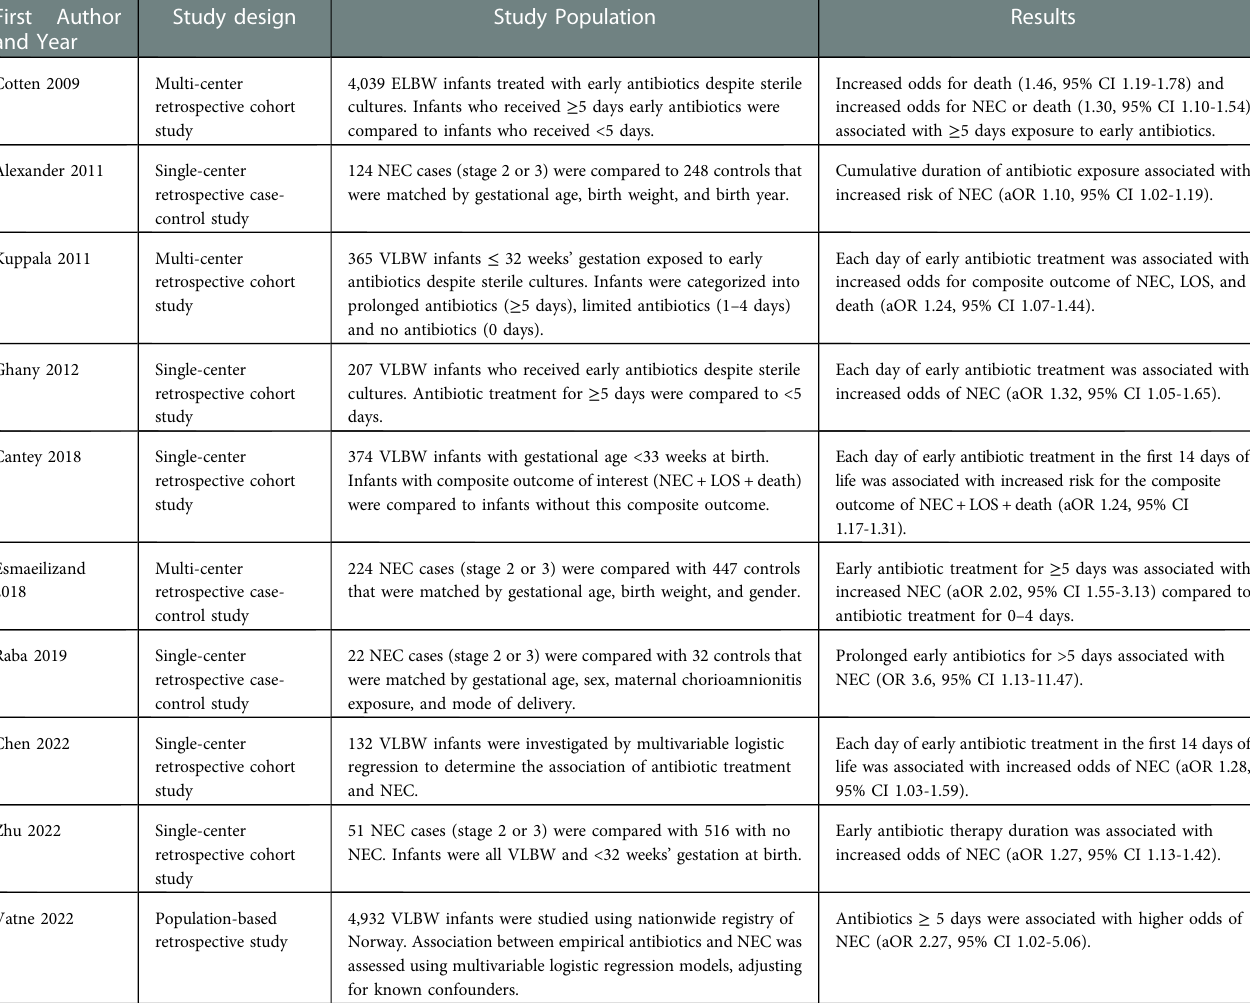
TABLE 2 Retrospective studies showing the association between prolonged early antibiotics and